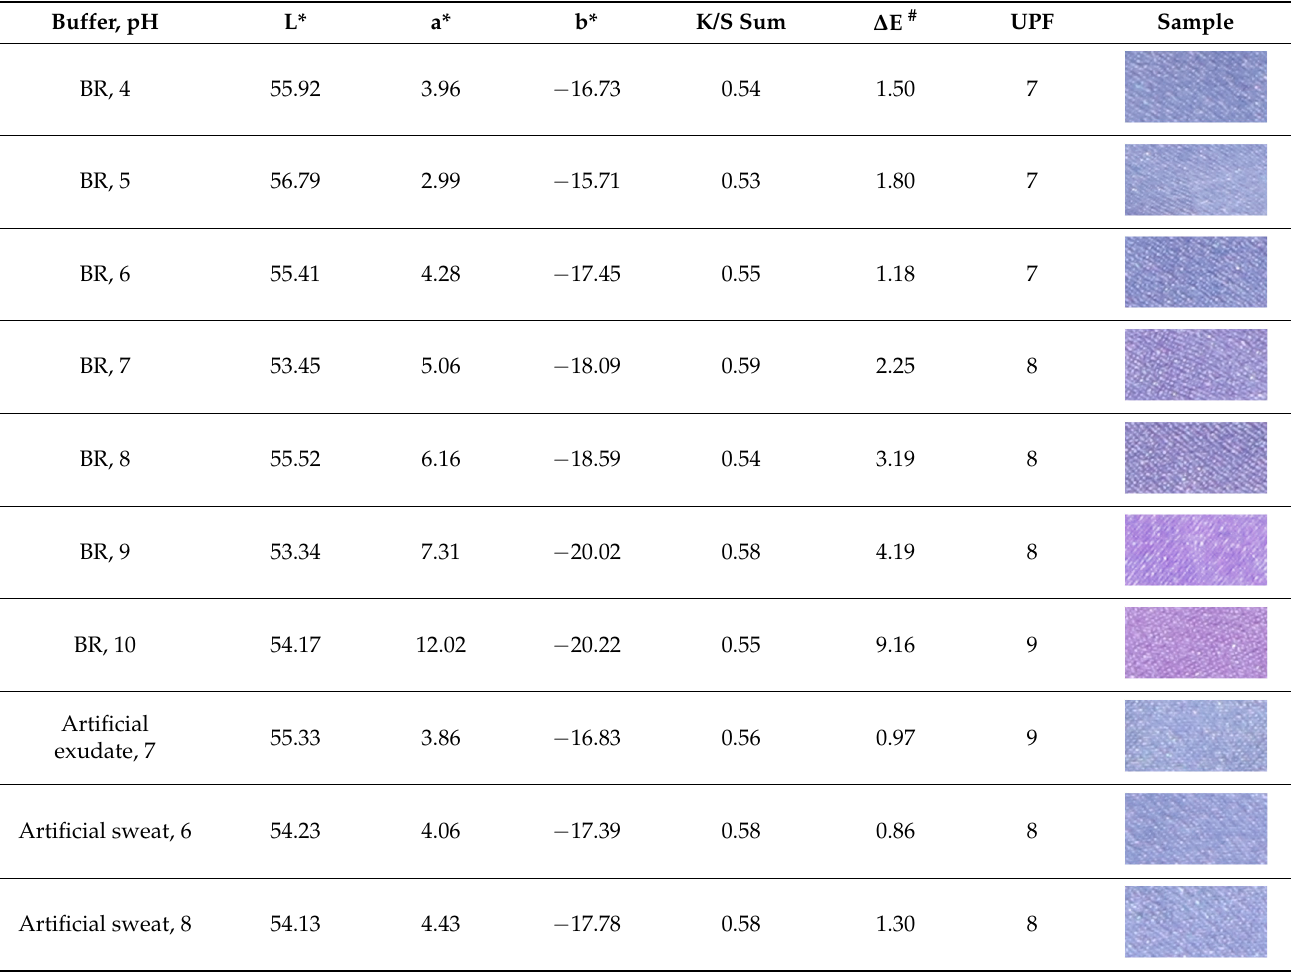
Figure 5. ( a ) Silk samples dyed at pH 6 dipped in di ff erent bu ff er solutions and corresponding color change at higher pH; ( b ) K/S spectra of silk fabrics dyed at pH 6 and dipped for 1 h in di ff erent bu ff er solutions (BR, Bri tt on–Robbinson, AE–arti fi cial wound exudate, S–arti fi cial sweat). Table 6. Color coordinates (L*-lightness, a*-yellowness/blueness, and b*-redness/greenness), K/S, ∆ E, and UPF of the samples functionalized with AzoIz.Pip and immersed in buffer solutions to assess the halochromic properties of the samples.